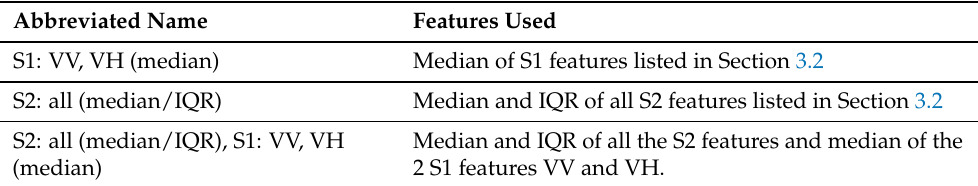
Table 6. Abbreviations used with their corresponding sets of features used for outlier detection. Each abbreviation can be read as follows: “S2: pixel-level features (parcel-level statistics), S1: pixel-level features (parcel-level